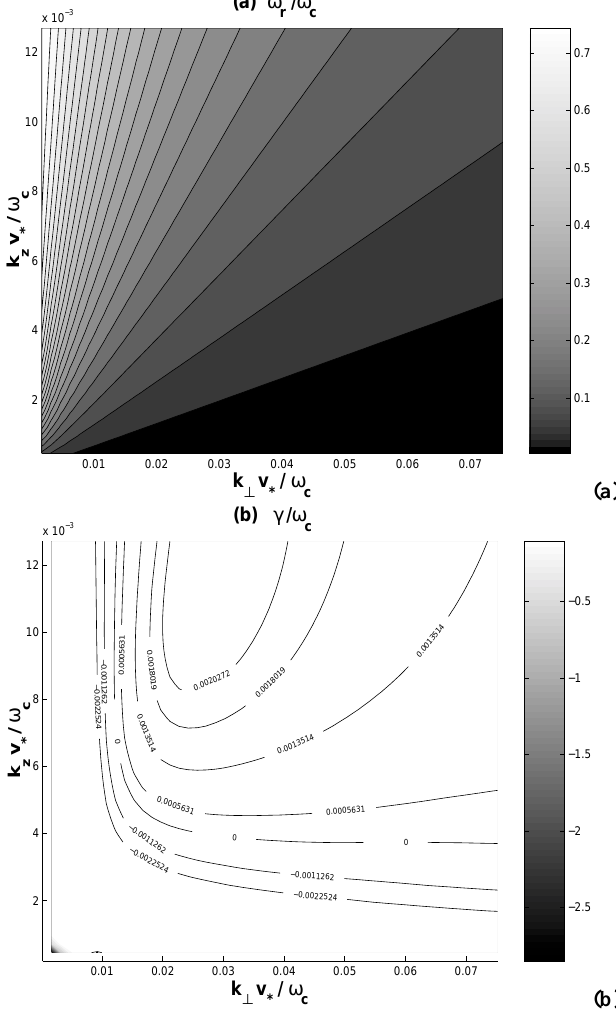
Fig. 3. Numerical calculations for auroral plasma conditions: con- tour lines of constant level of (a) the normalized frequency ω r /ω c as a function of the normalized parallel and perpendicular wave numbers k z v ∗ /ω c and k ⊥ v ∗ /ω c , and (b) the normalized growth rate γ/ω c as a function of k z v ∗ /ω c and k ⊥ v ∗ /ω c . The solar wind pa- rameters are: ω p /ω c ’ 0 . 8 , ω c / 2 π ’ 1 . 15MHz, ω p / 2 π ’ 0 . 9 MHz, T e ’ 0 . 2eV . For (b), the values of the calculated growth rates are indicated on the